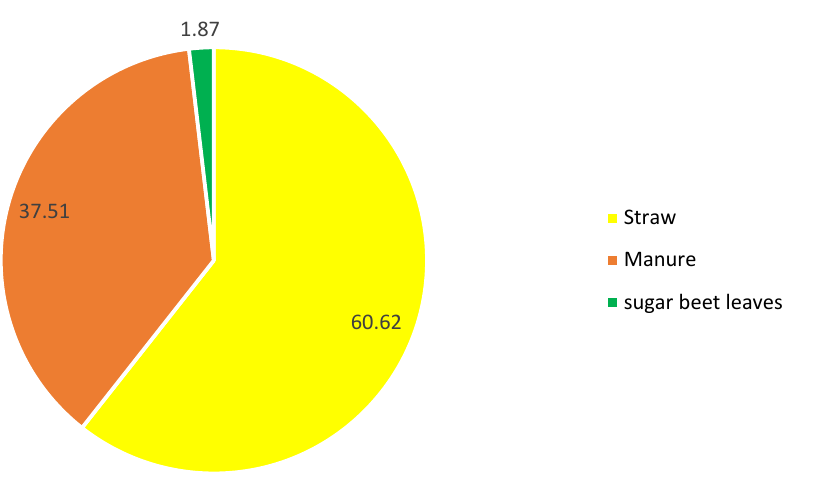
Figure 8. Structure of energy potential, %.